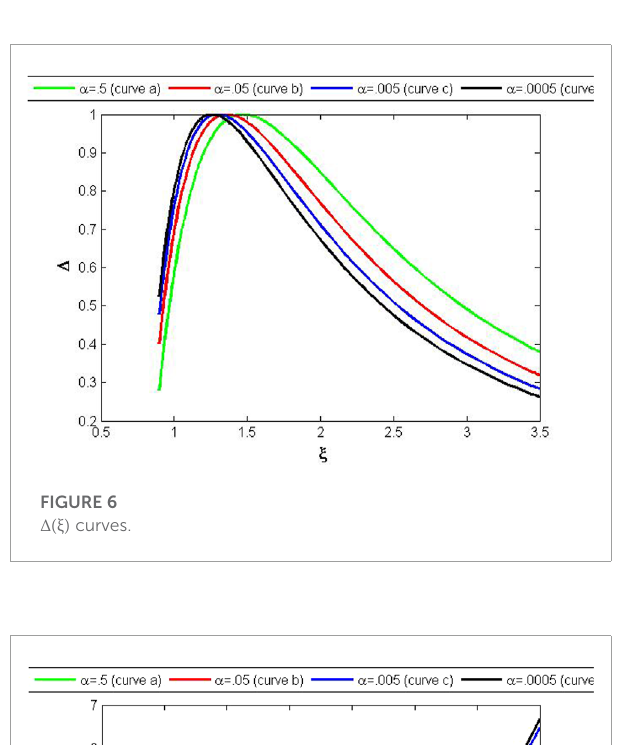
FIGURE 5 ψ ( ξ ) curves.